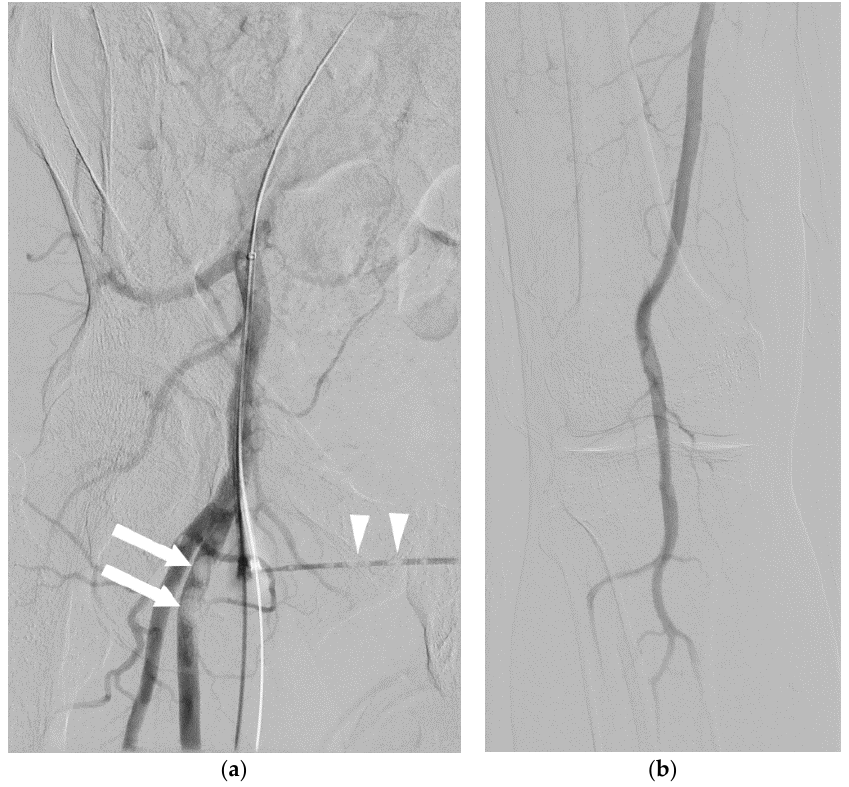
Figure 2. A 61 ‐ year ‐ old male underwent an initial femoral angiogram ( a ), which revealed a small amount of air in the tubing of the side port (arrowhead) that had traveled into the superficial femoral artery (arrows). As the lower extremity arteriogram ( b ) revealed no visible distal emboli, it was presumed the air was resorbed. There were no adverse sequelae.